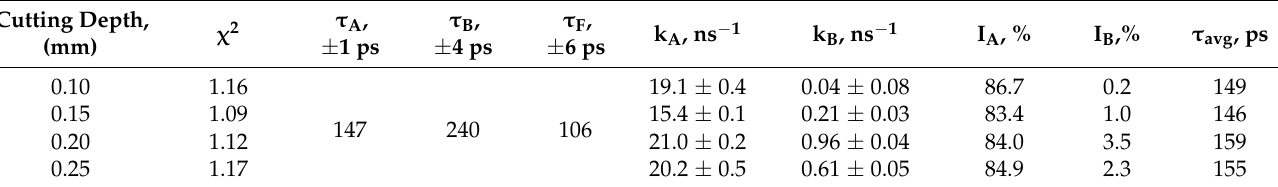
Table 5. Dependence of PALS parameters of GCr15 samples on cutting